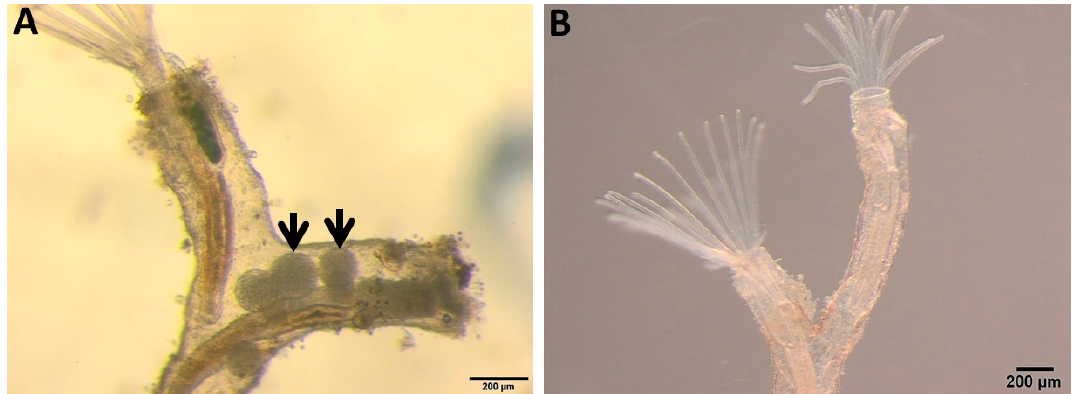
Figure 9. Bryozoan Fredericella sultana zooids. ( A ) Infected zooids showing parasite sacs (arrows) inside the body cavity. ( B ) Uninfected control zooids.